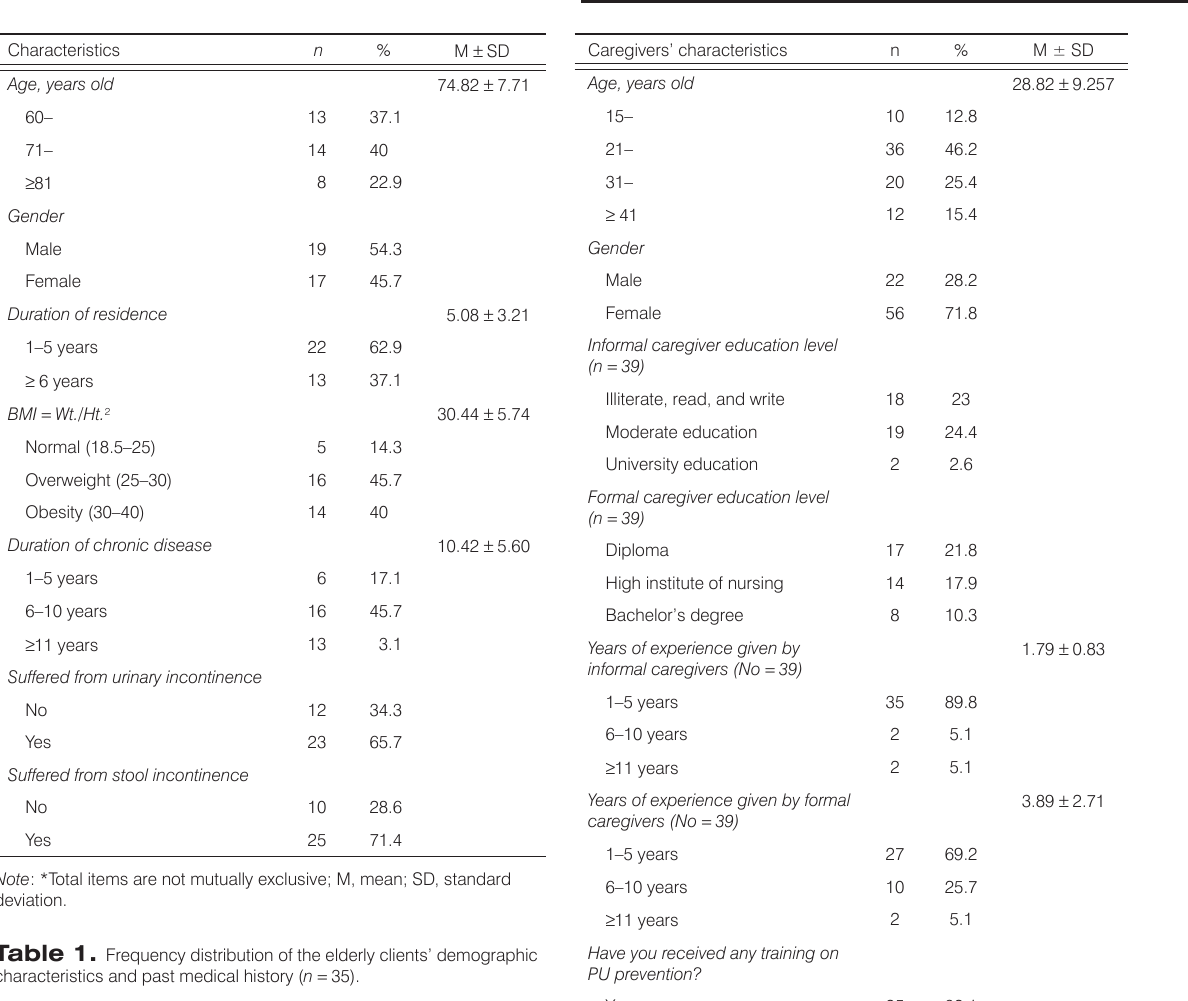
Table 1. Frequency distribution of the elderly clients’ demographic characteristics and past medical history ( n = 35).